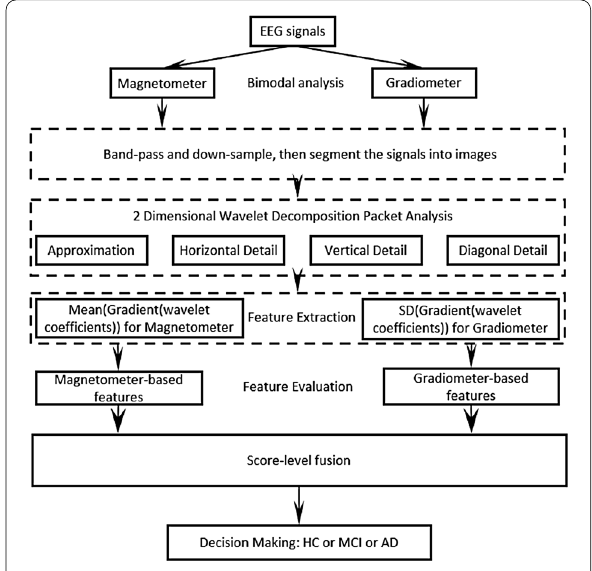
Fig. 1 Flow diagram of the proposed bimodal three‑class recognition